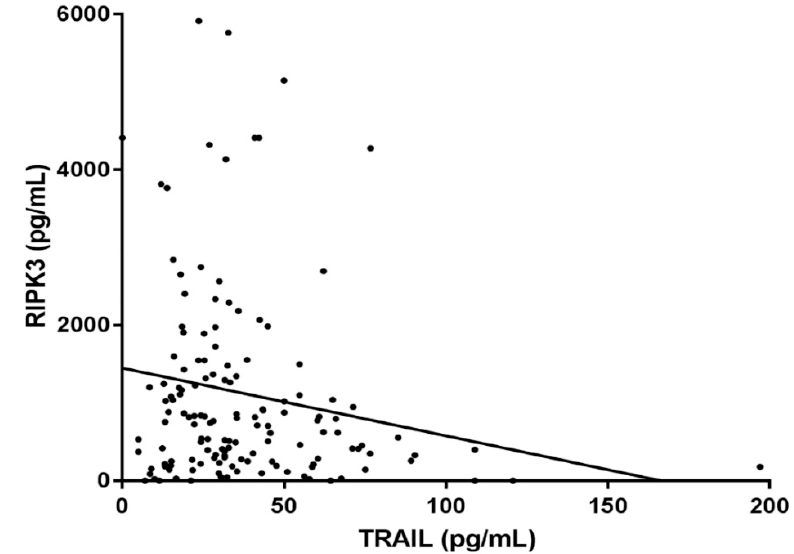
Figure 3. Correlation between plasma level of TRAIL and RIPK3 in patients with sepsis (n = 143). Slope: − 8.713 (95% CI: − 0.426– − 17.000), r 2 : 0.02973, Pearson’s r: − 0.172 ( p =